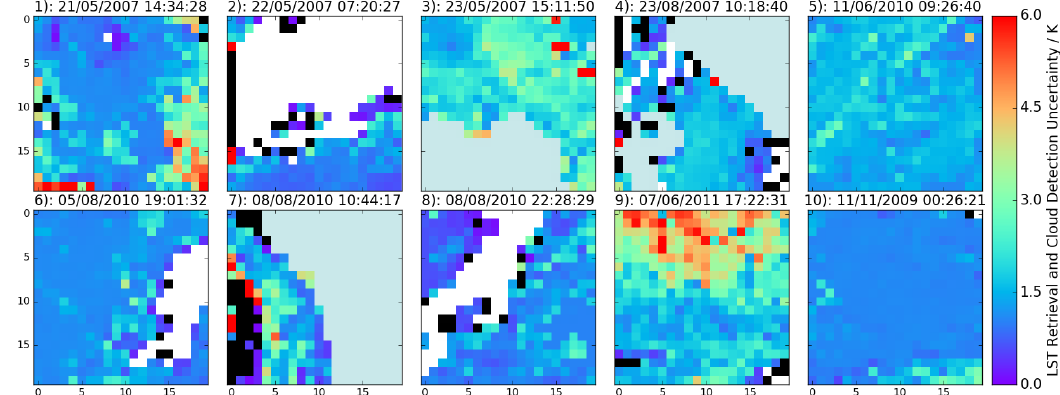
Figure 5. Combined Level 3 LST retrieval and cloud detection uncertainties for the 10 submission scenes in the cloud clearing inter-comparison (Figures 3 and 4) at 625-km 2 resolution. Individual plot headings give the scene number, date and orbit start time. White grid cells denote agreement between all masks on cloudy conditions. Black grid cells denote regions classified as entirely cloudy by the manual mask, but clear-sky in some of the contributing